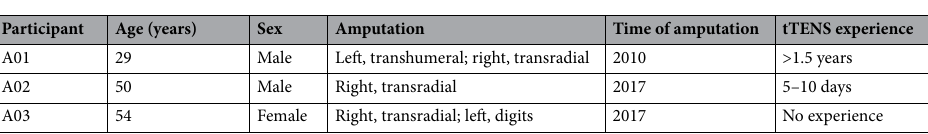
Table 1. Participant